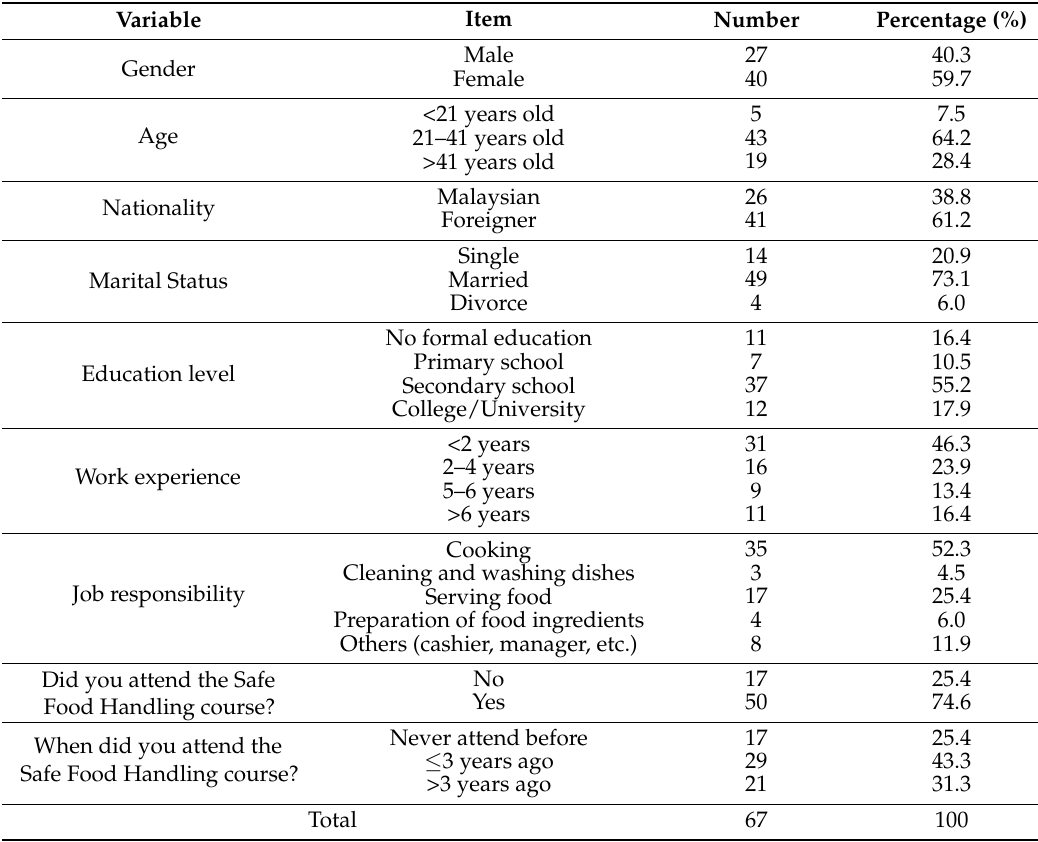
Table 1. Participant demographic